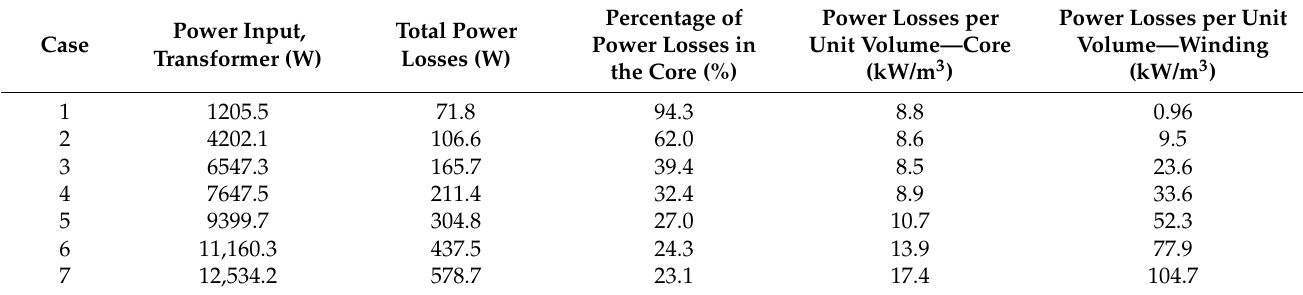
Table 1. Cases simulated, including the total power input in the transformer and the power loss per unit volume in each of the